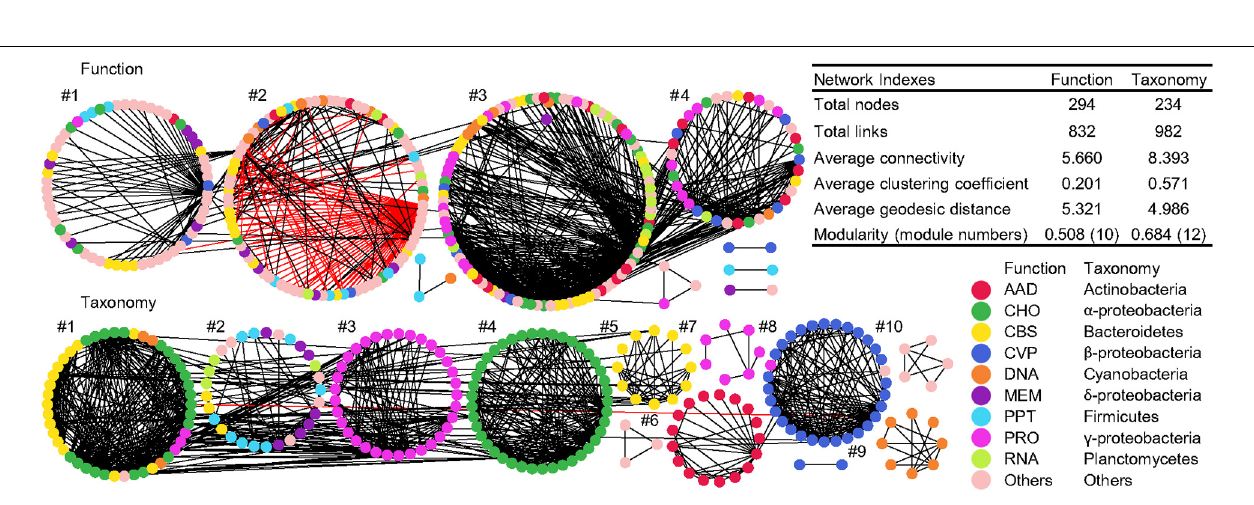
Frontiers in Microbiology |